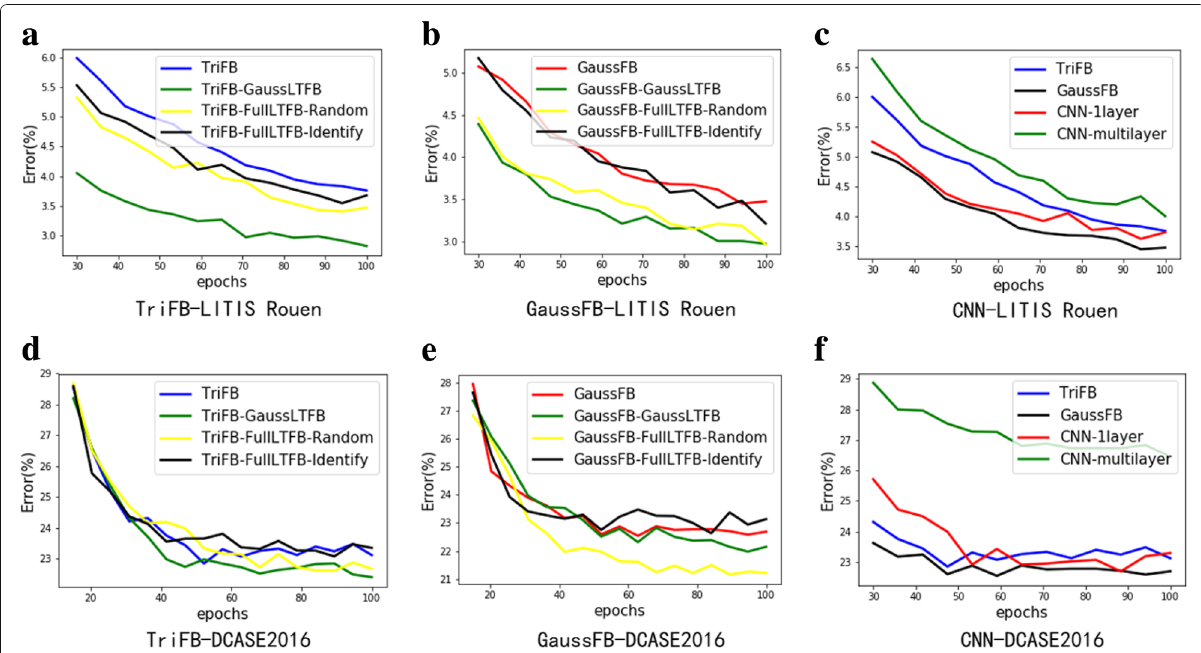
Fig. 7 Validation curves on LITIS ROUEN dataset and DCASE2016 dataset. a , b The proposed methods on LITIS ROUEN dataset. d , e The proposed methods on DCASE2016 dataset. c The classical CNN nodels on LITIS ROUEN dataset. f The classical CNN nodels on DCASE2016 dataset